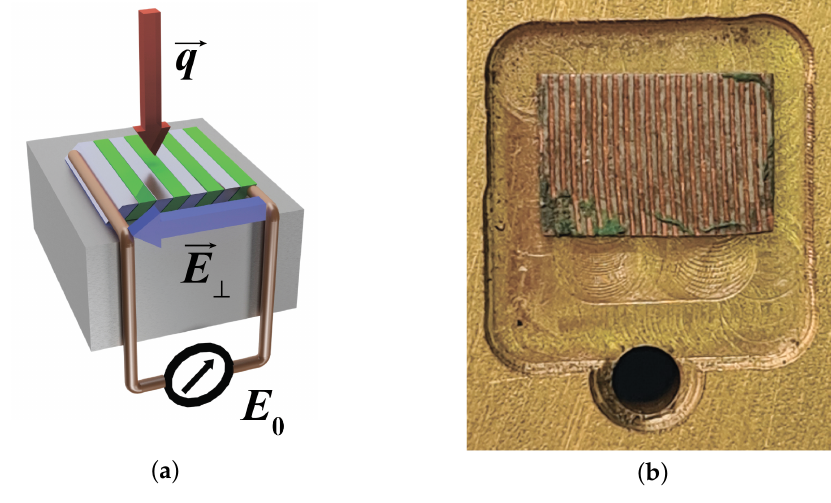
Figure 3. HGHFS scheme ( a ) and general view ( b ).